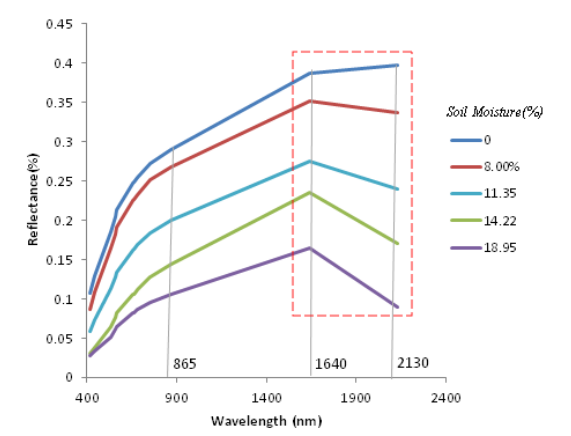
Fig. 2 Spectral Reflectance curve of Soil (slope variation between bands 1640 nm and 2130 nm)